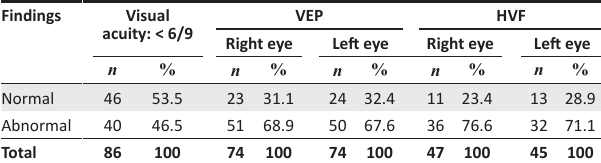
TABLE 3: Frequencies of abnormal visual acuity, visual evoked potentials and Humphreys visual fields in 86 patients tested. Findings